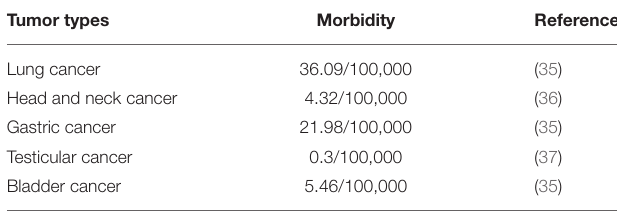
TABLE 4 | Utility values of outcomes in acute and delayed phases. TABLE 5 | Morbidities of five